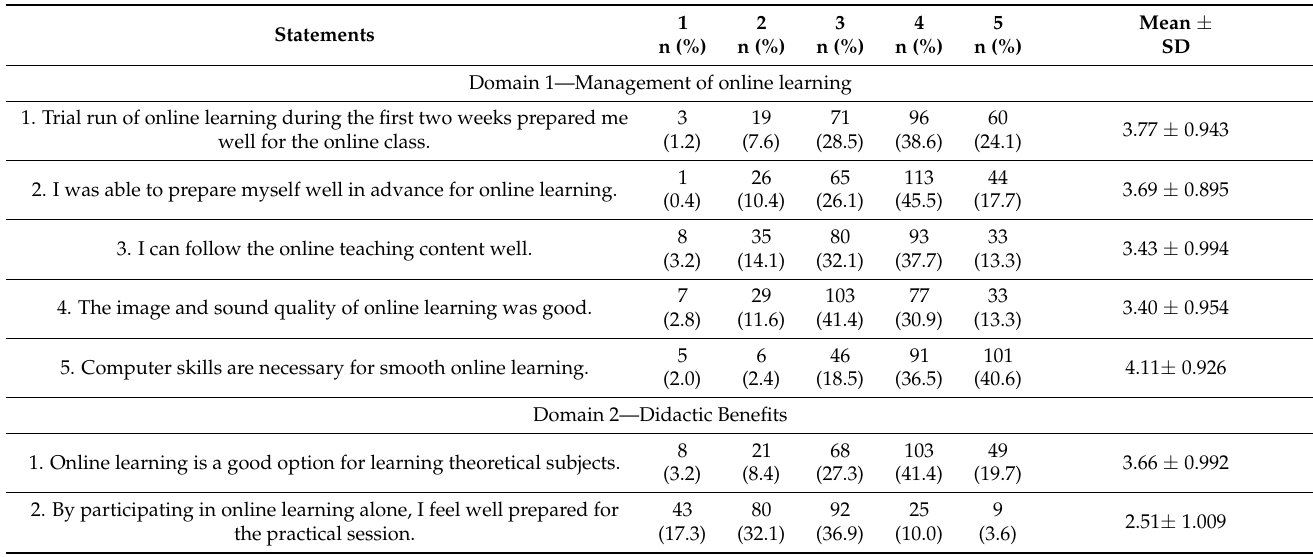
Table 1. Assessment of Domain 1 (management of online learning), Domain 2 (didactic benefits), Domain 3 (motivations), and Domain 4